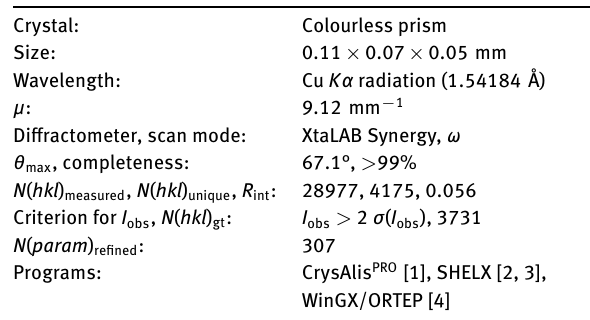
Table 1: Data collection and